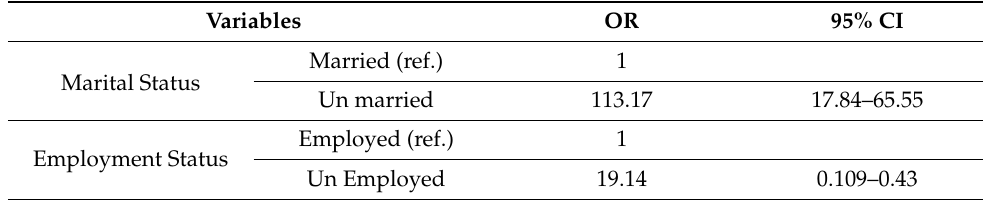
Table 6. Predictors of the children vaccination opposition using multivariate logistic regression